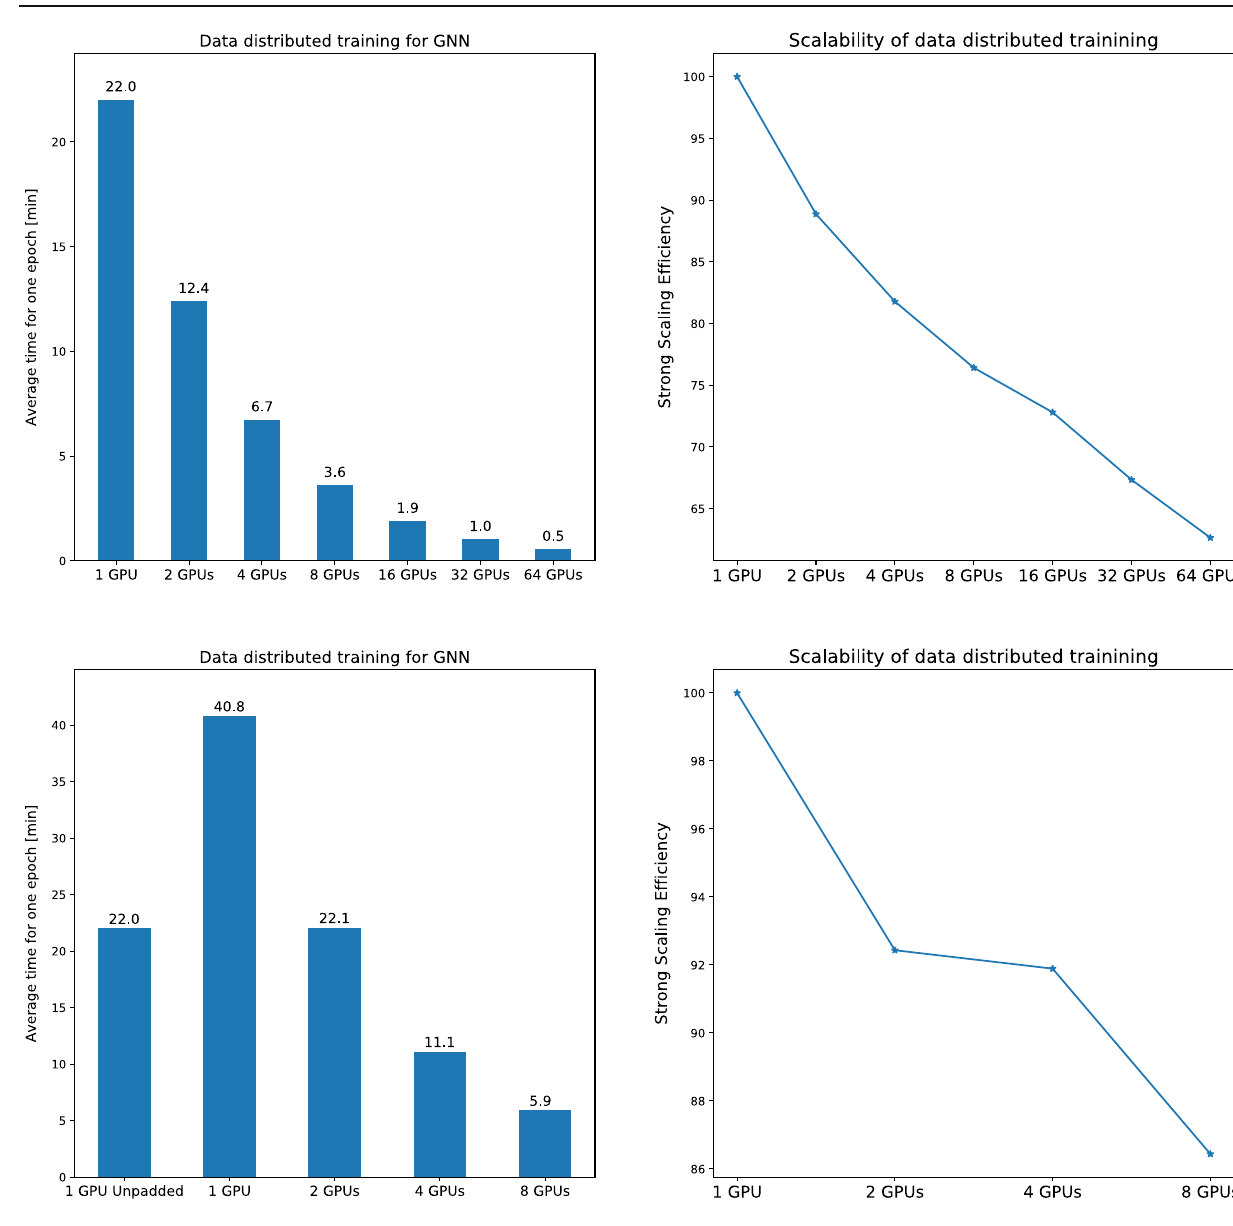
Fig. 8 Time per training epoch (left) and Strong scaling efficiency (right) for GNN’s distributed training. The top row refers to the Horovod implementation, the bottom row to the tf.distributed one. The first bin in the bottom left diagram refers to the serial case, in which the input graph is not